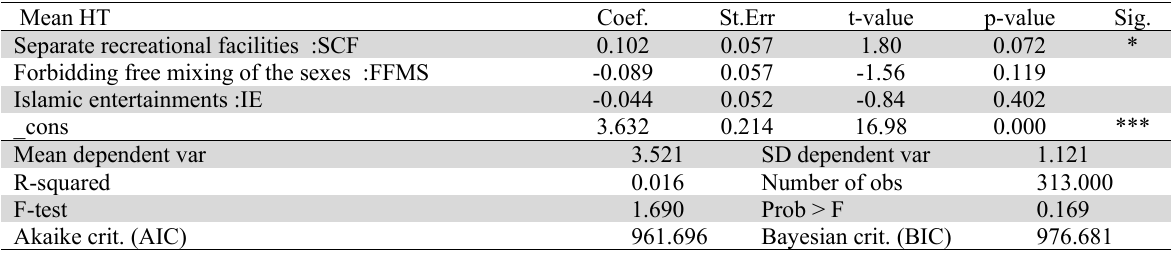
Misc. Islamic Factors and Halal